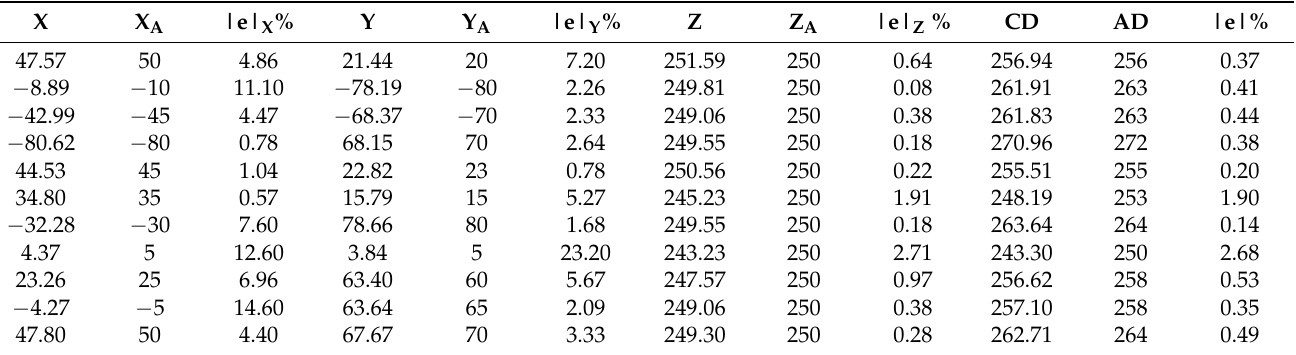
Table 4. Binocular camera range results when Z = 250 (unit: mm).